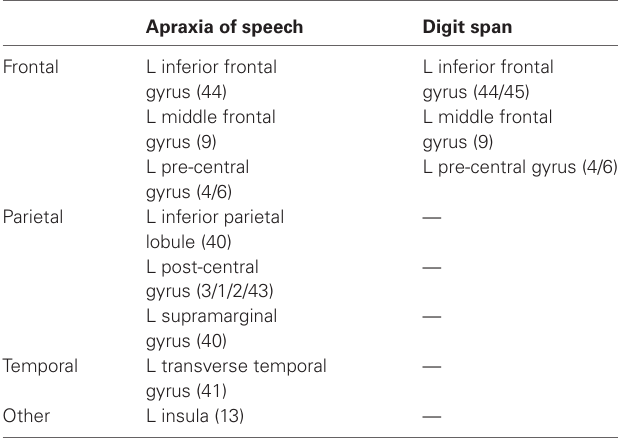
Table 1 | Anatomical locations containing significant voxels in the apraxia of speech and digit span VLSMs, respectively . Apraxia of